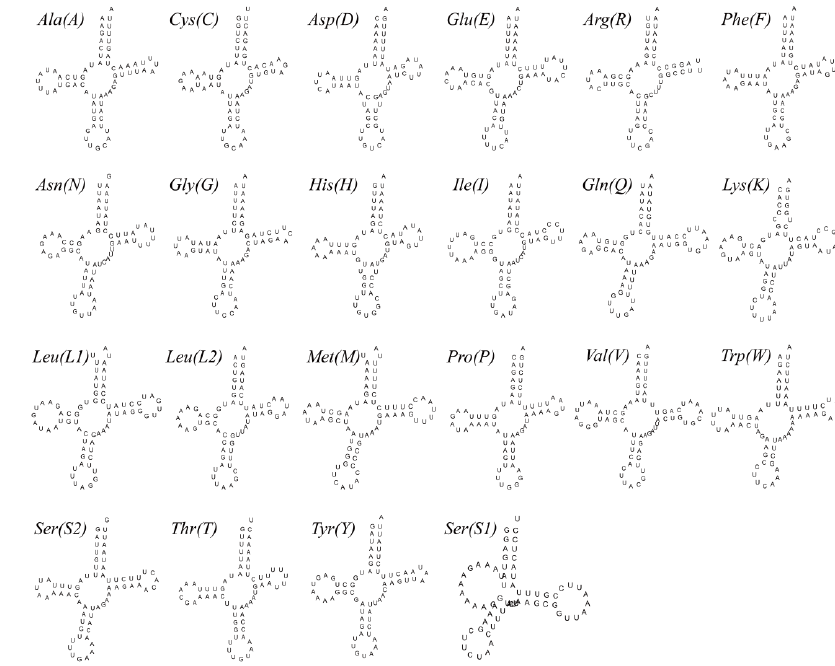
Figure 3. Secondary structures of tRNAs of the P. makianus mitogenome.